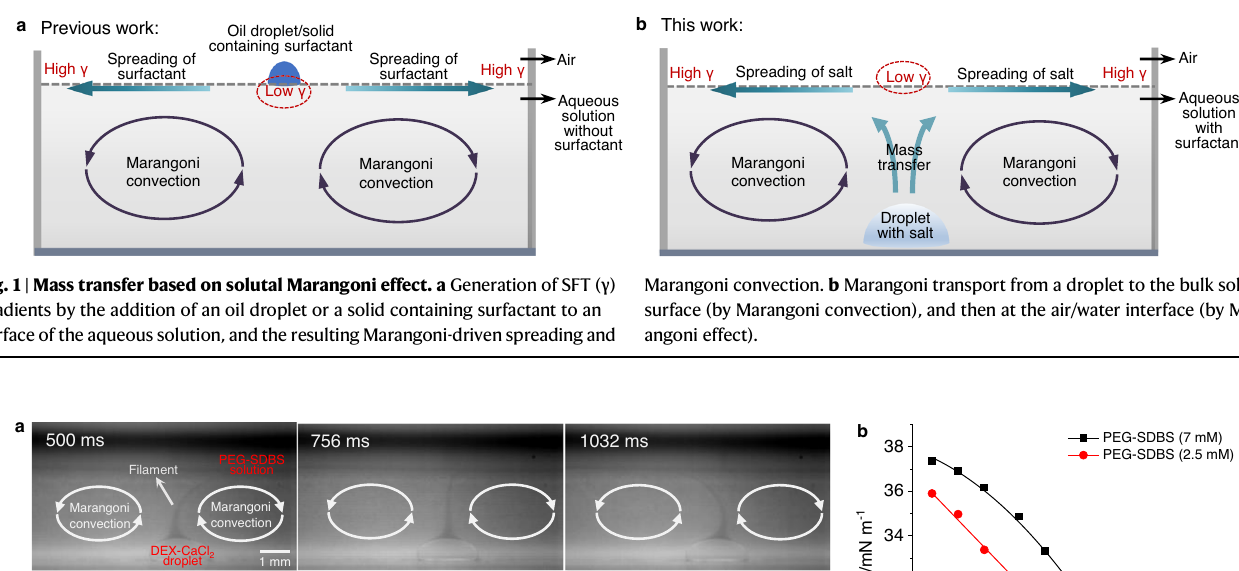
Fig. 2 | Generation of Marangoni convection by CaCl 2 induced SFT decrease of SDBS solution. a Generation of Marangoni convection (indicated by white ovals) by the addition of a droplet of DEX-CaCl 2 (100mM) to a solution of PEG-SDBS (7mM)inaglasscuvette(24×24×24mm).Hollowglassbeads(diameter8 – 12 μ m,